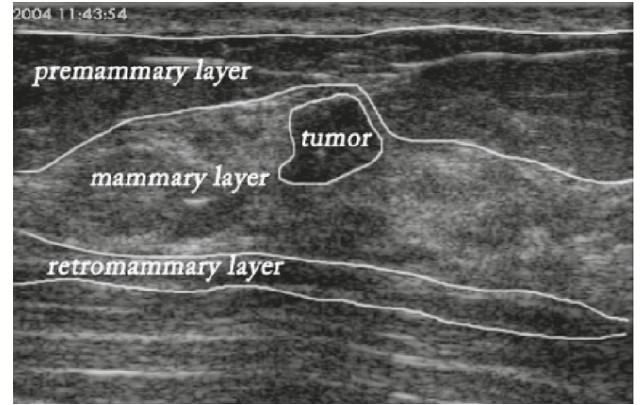
Figure 3. Major breast layers of a sample BUS image.